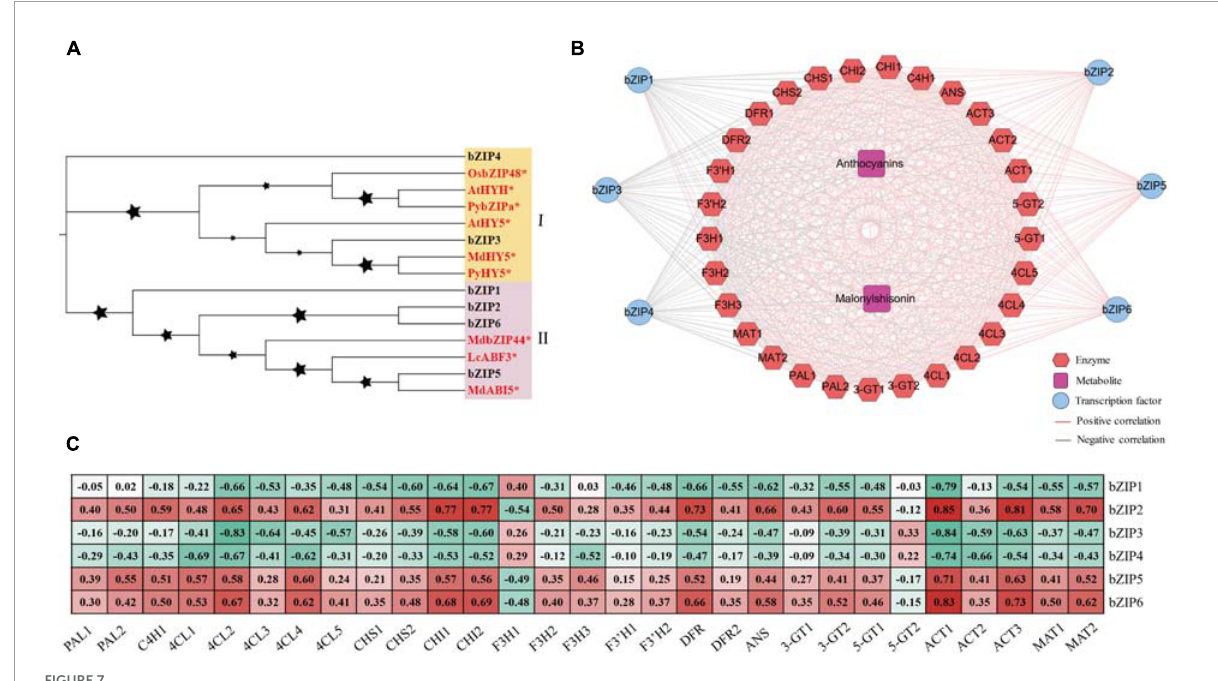
FIGURE7 The bZIP transcription factors involved in the light response and anthocyanin regulation in perilla. (A) Phylogenetic relationships of bZIP transcription factors. Yellow and pink background indicate two subclasses in the evolutionary tree. The stars next to the nodes represent bootstrap values of 1000 replicates. The red font and symbol ∗ indicate that these objects have been reported. (B) Co-expression networks between candidate bZIPs. (C) Correlation coefficients between candidate bZIP transcription factors and key anthocyanin biosynthesis genes. At, Arabidopsis thaliana ; Py, Pyrus pyrifolia ; Os, Oryza sativa Japonica; Md, Malus domestica ; Lc, Litchi chinensis